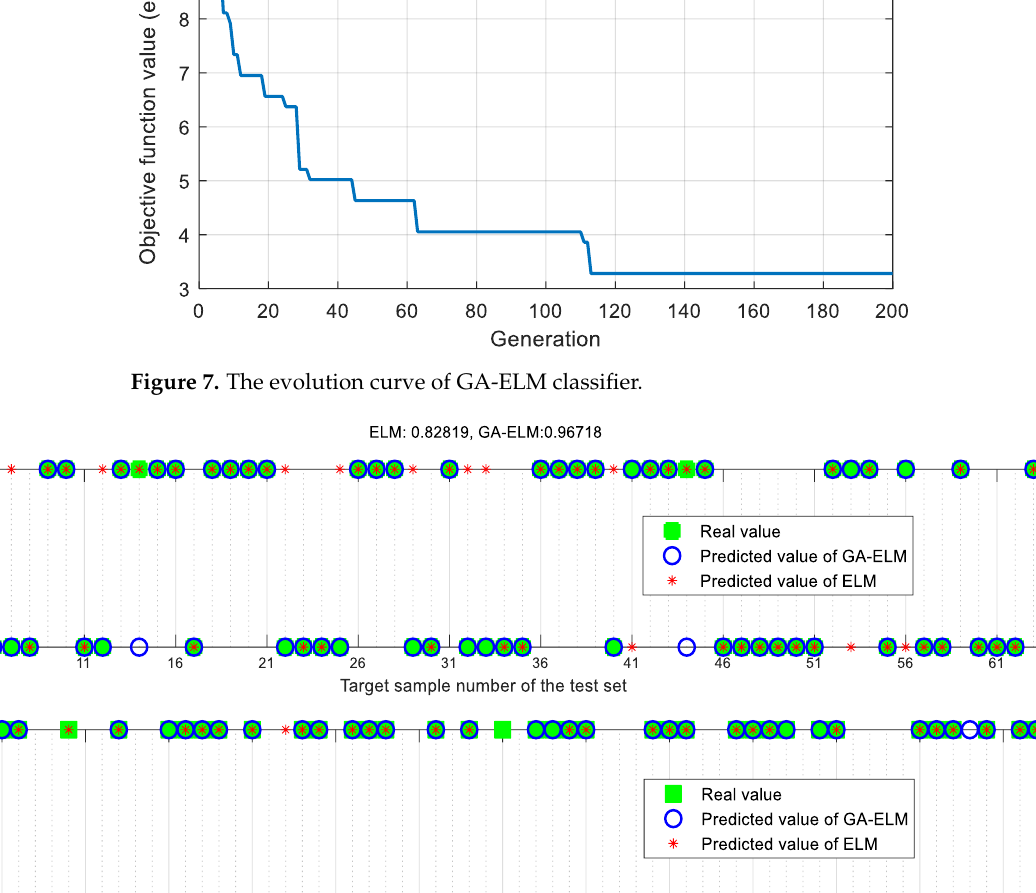
Figure 8. The comparison of the discriminant results of the test set.